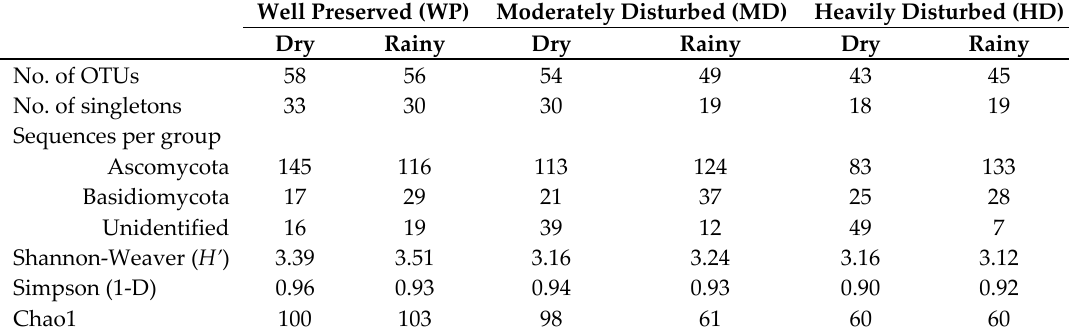
Table 3. Number of fungal OTUs, singletons, and diversity indices for three forest sites with increasing levels of disturbance in central Mexico in two contrasting seasons. Well Preserved (WP) Moderately Disturbed (MD) Heavily Disturbed